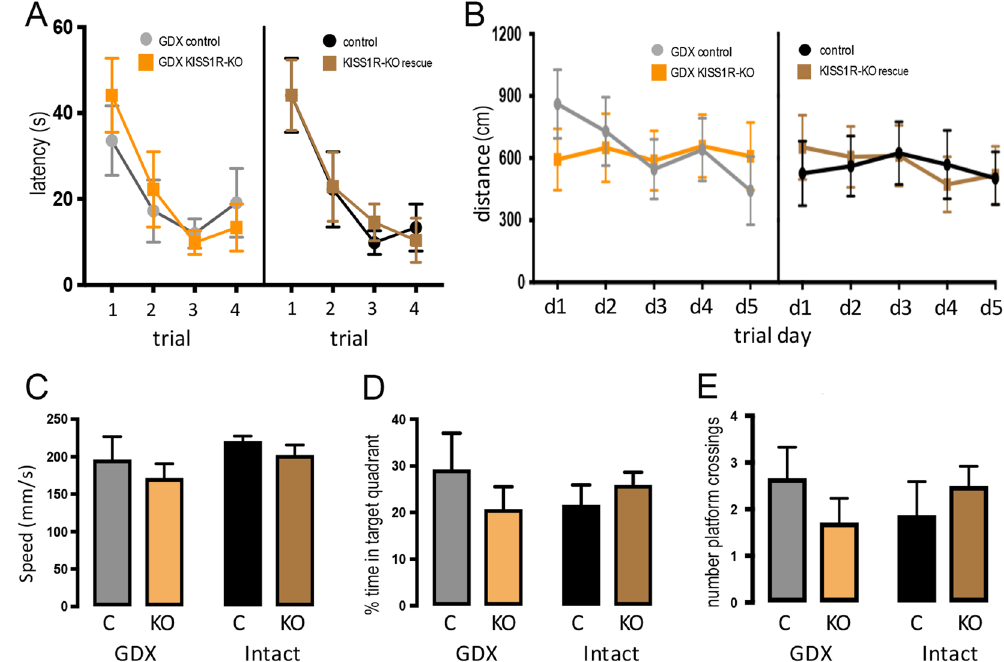
Figure 3. Morris water maze performance of GDX control (GDX C; N = 9), GDX KISS1R-KO (GDX KO; N = 7), intact control (Intact C, N = 8), and intact KISS1R-KO rescue (Intact KO, N = 9) mice. ( A ) Latency to reach a cued platform across 4 daily trails. GDX and intact groups are displayed side-by-side for clarity. No significant differences were detected between any of the 4 groups ( P > 0.05; repeated-measures 2-way ANOVA). ( B ) Distance travelled to reach a hidden platform in the NE quadrant across the 5 trial days. GDX and intact groups are displayed side-by-side for clarity. No significant differences were detected between any of the 4 groups ( P > 0.05; repeated-measures 2-way ANOVA). ( C – E ) Performance of mice in probe tests where the platform was removed. No significant differences were detected in swim speed, percentage of time spent in the target quadrant, or the number of times the mice crossed the prior location of the training platform ( P > 0.05; 2-way